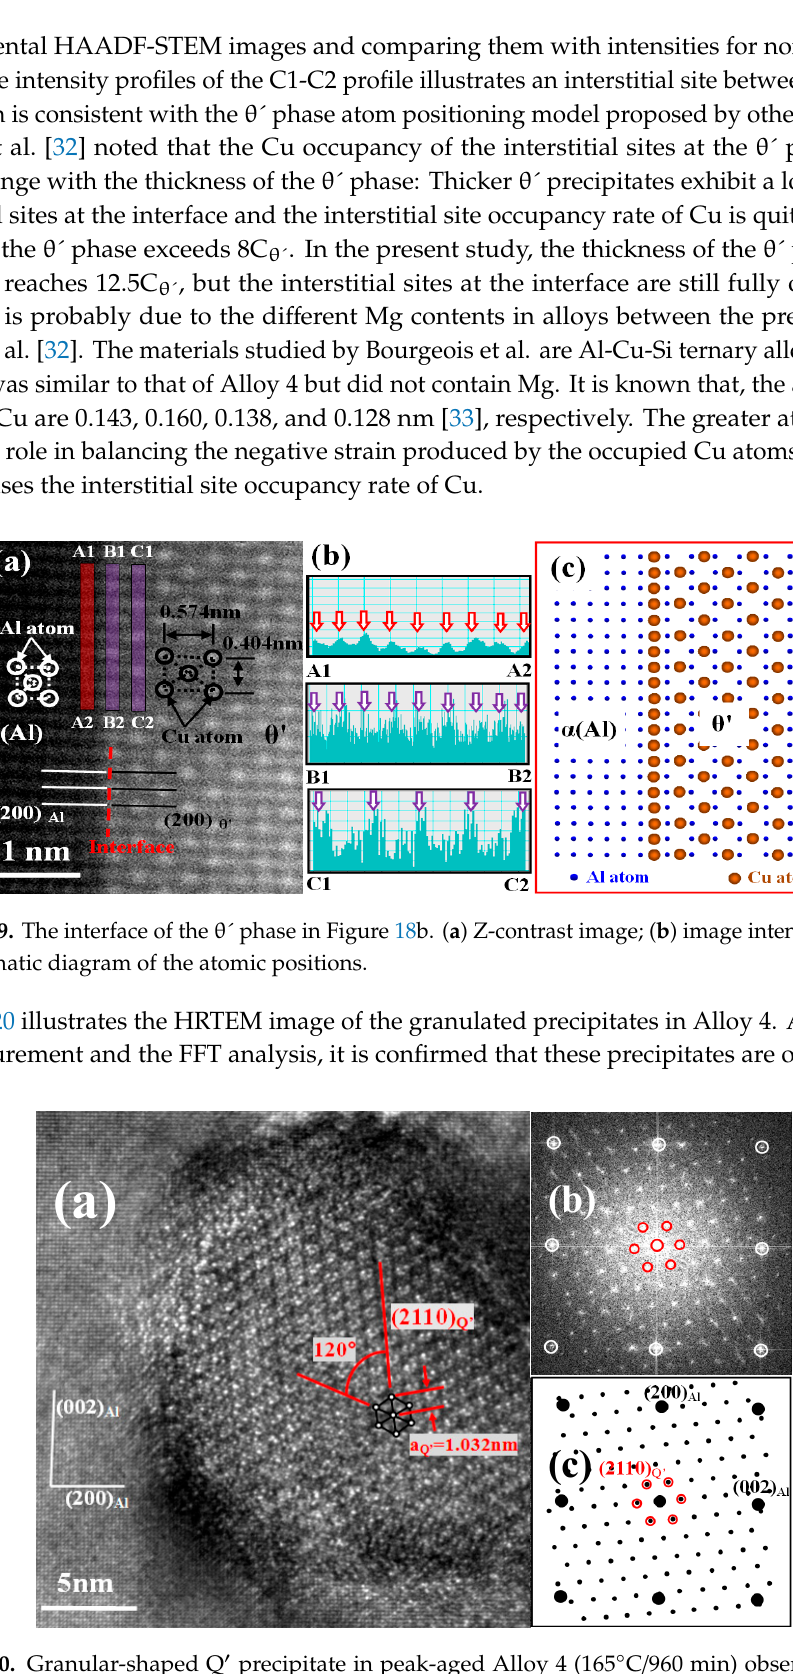
Figure 20. Granular-shaped Q’ precipitate in peak-aged Alloy 4 (165°C/960 min) observed via the <010> Al direction: ( a ) HRTEM image, ( b ) corresponding FFT, and ( c ) simulated pattern.